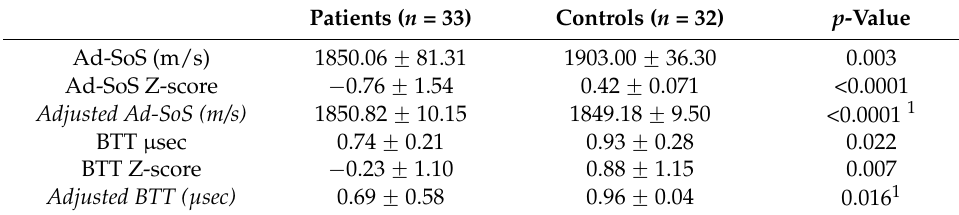
Table 4. Quantitative ultrasound of the phalanges